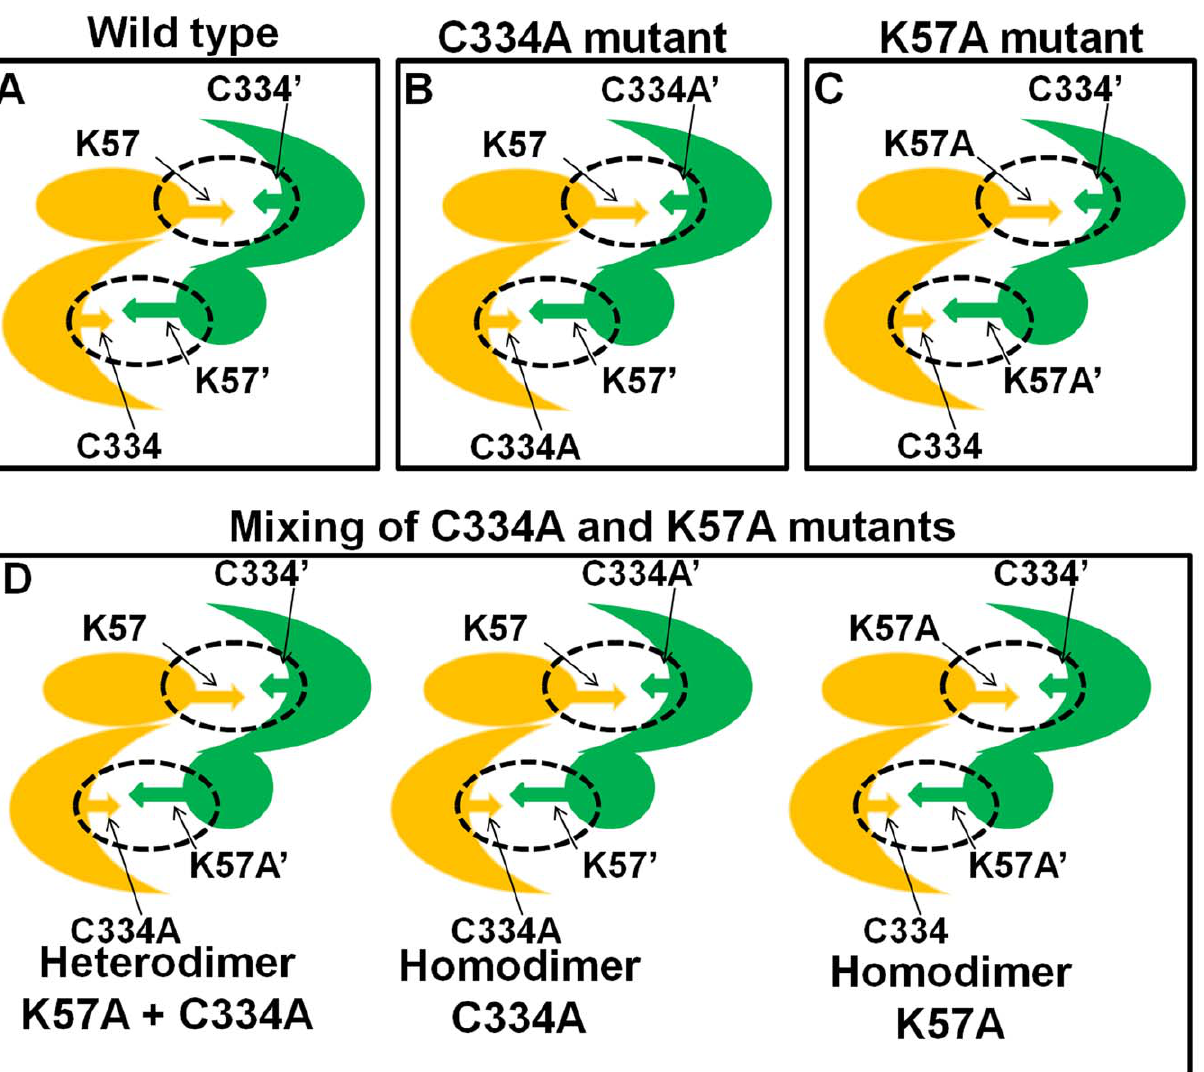
Figure 11. Schematic representation of homodimers and heterodimer in the mixture of Eh ODC Cys334Ala and Lys57Ala mutants. (A–C) Homodimer formation of wild-type and mutants of Eh ODC in individual solutions. (D) Possible combinations of Eh ODC monomeric subunits in the mixture of Cys334Ala and Lys57Ala mutants forming heterodimer and homodimers.